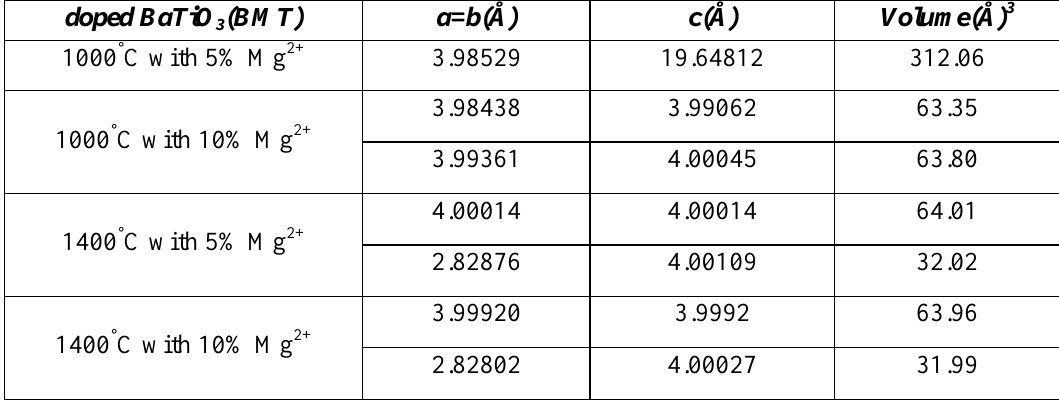
Table 2: Lattice parameter of doped (BMT) in